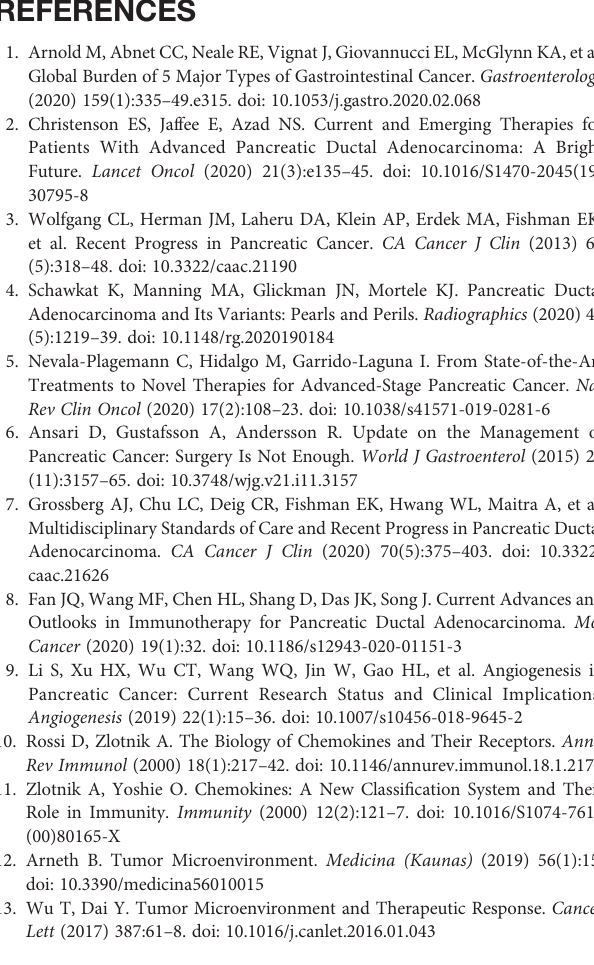
Supplementary Figure 4 | Correlations between the expression of CXC chemokines and BRCA2 mutated genes (cBioportal). Supplementary Figure 5 | The pathway and process enrichment analysis of CXC chemokines (Metascape). (A) Bar graph of enriched terms across input CXC chemokines, colored by p-values. (B) The top-level Gene Ontology biological processes. (C) Network of enriched terms, colored by cluster ID, (D) Network of enriched terms, colored by p-value. Supplementary Figure 6 | The comparison of tumor in fi ltration levels among PAAD with different somatic copy number alterations for CXC chemokines (TIMER). Supplementary Figure 7 | Kaplan – Meier curves for visualizing single CpG of CXC Chemokine together with their prognostic value in PAAD (MethSurv). Supplementary Figure 8 | The expressions levels and prognostic values of CXC chemokines signature in validation cohort (SurvExpress). (A) The heatmap of CXC chemokines in PAAD patients in high- and low-risk group. (B) The expression levels of CXC chemokines between high- and low-risk groups. (C) Kaplan – Meier curves forsurvivalanalysisofCXCchemokinesbetweenhigh-andlow-riskgroups. (D) The survivalROC curves for survival prediction by the CXC chemokines assessed the accuracy of prognostic model. Supplementary Figure 9 | External validation of the prognostic value of single CXC chemokine in independent GSE62452 cohort (GEO